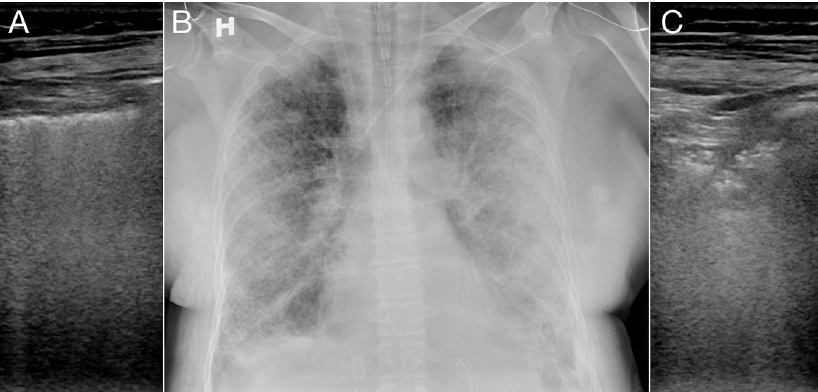
Figure 7. A patient with corresponding LUS and chest X-ray is shown. The ultrasound images are taken from the lateral view of each lung. The interstiel edema in the right lung visible with LUS as increased B-lines ( A ) is seen as numerous kerley B-lines in the chest X-ray ( B ). The consolidations with air-bronchograms in the left lung visible with LUS ( C ) are seen as subpleural consolidations in the chest X-ray ( B ).